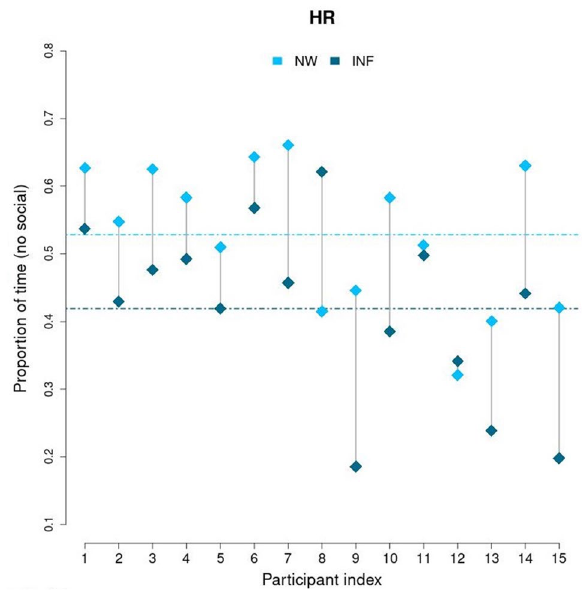
Figure 5. Observed proportion of time fixation in Task 2, Averted vs. direct eye-gaze, for individuals measured at birth (NW = Newborns, light blue color) and at 4 months (INF = Infants, dark blue color). Note that dotted colored lines represent observed means for both time